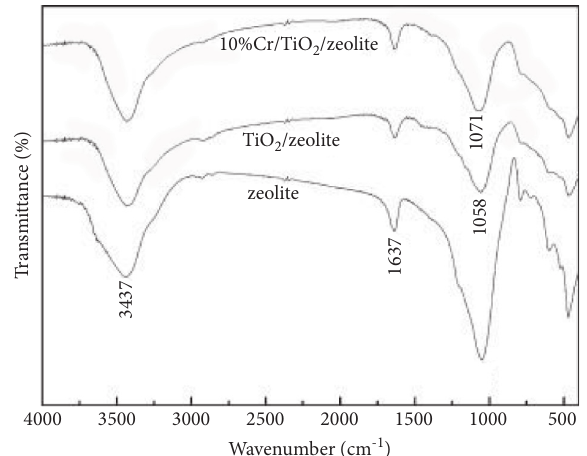
Figure 7: FT-IR spectra of zeolite, TiO zeolite adopted from [10].